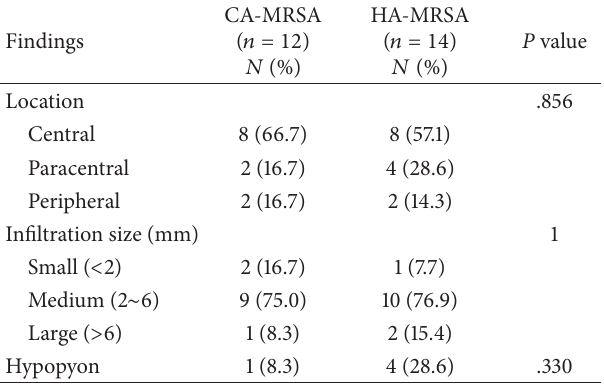
Table 2: Clinical findings of community-associated methicillin- resistant Staphylococcus aureus (CA-MRSA) and healthcare- associated methicillin-resistant Staphylococcus aureus (HA-MRSA)